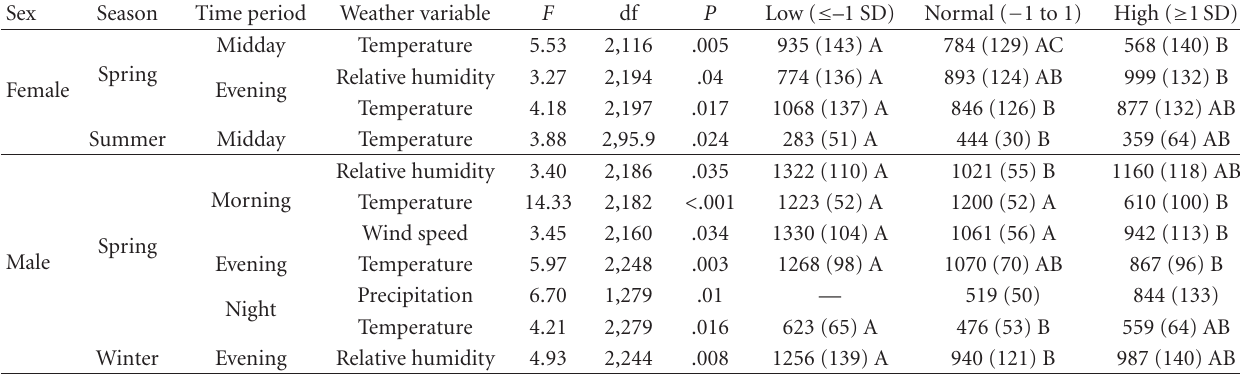
Table 4: Di ff erences in mean ( ± SE) movement relative to weather conditions. Weather conditions were classified as below normal (i.e., low) if ≤ 1SD from mean, above normal (i.e., high) if ≥ 1 SD from the mean, and normal if SD was − 1 to 1. Values with the same letter did not di ff er at α = 0 .